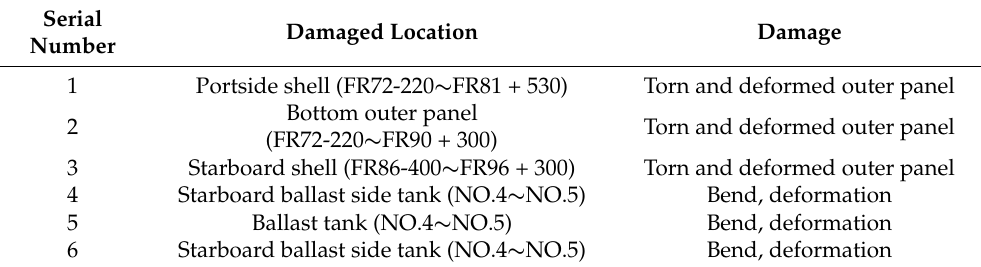
Figure 6. Overall damage to the port skin. Table 2. Hull damage. Table 2. Hull damage.